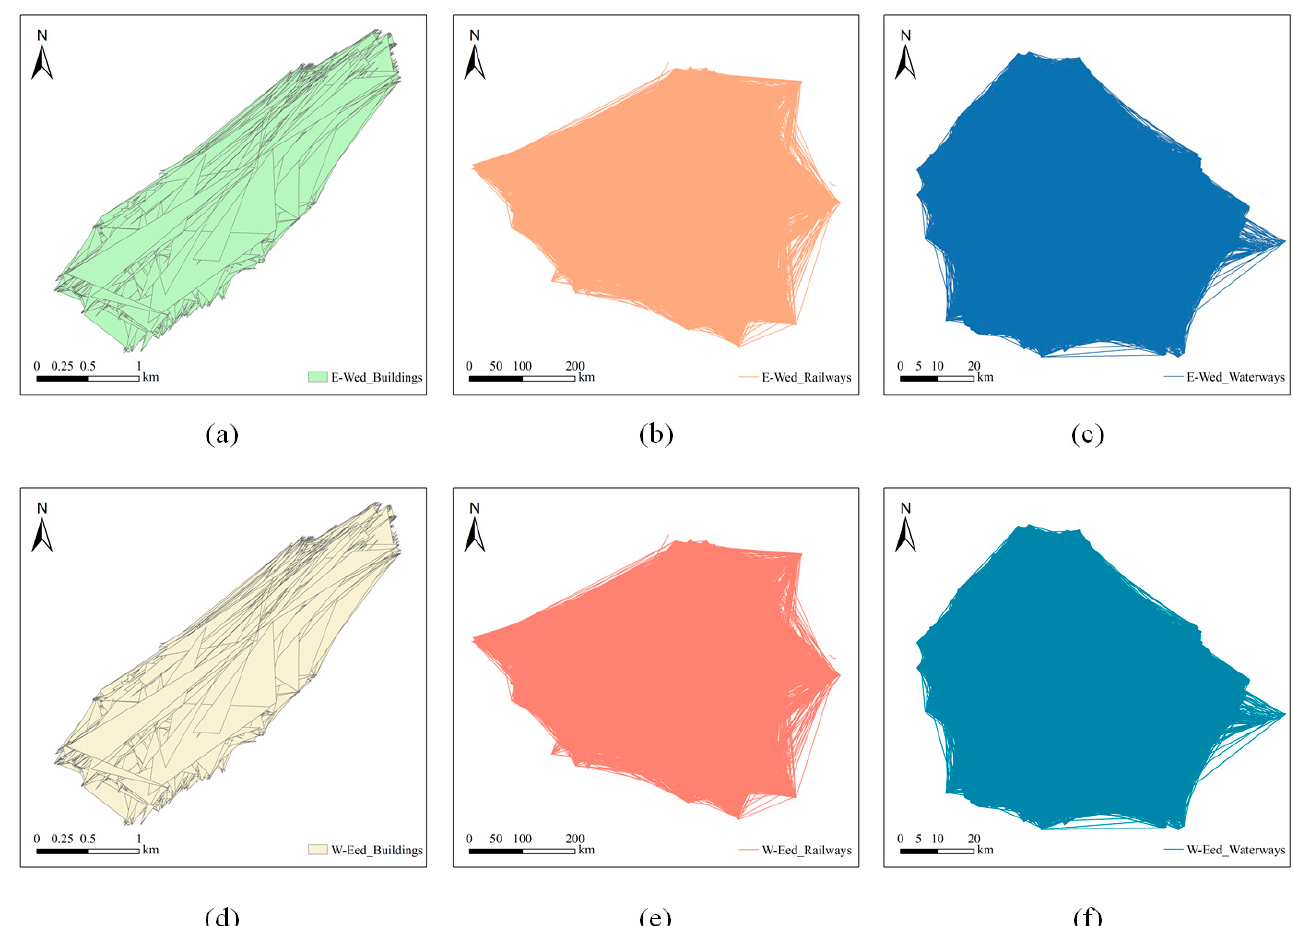
Figure 7. The visualization results of CEWed maps. ( a ) E-Wed buildings, ( b ) E-Wed railways, ( c ) E-Wed waterways, ( d ) W-Eed buildings, ( e ) W-Eed railways, ( f ) W-Eed waterways.